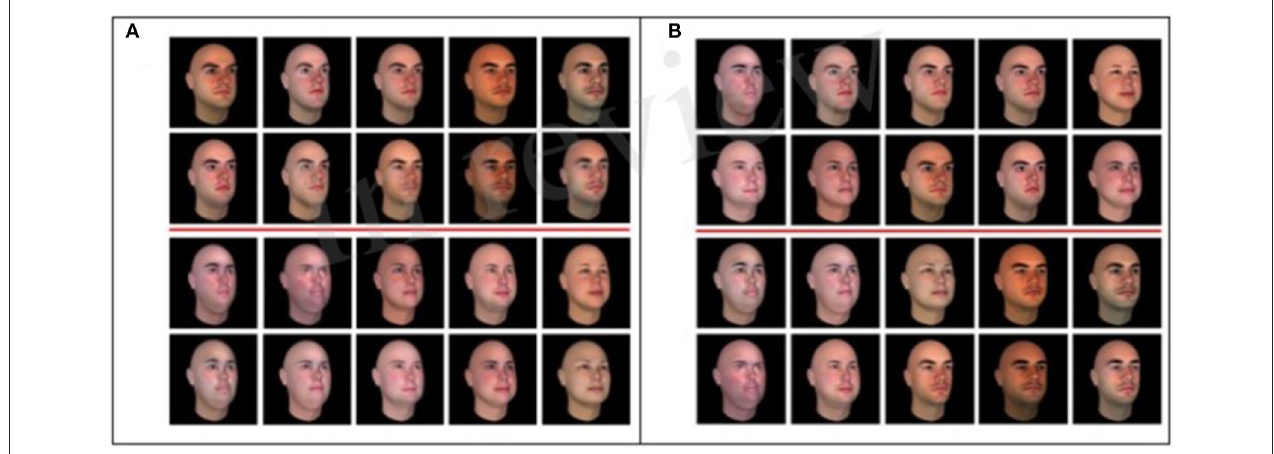
FIGURE 2 | The final high dimensional (A) filtration separable (FS) and (B) condensation integral (CI) sets with the categorization lines indicated in red.